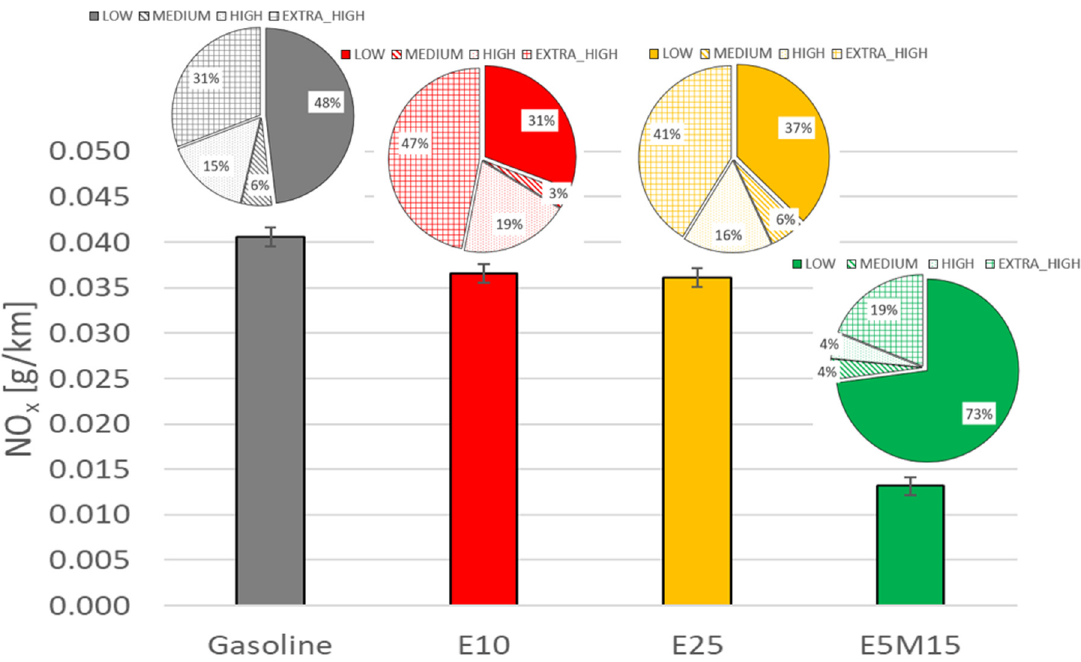
Figure 8. NO x emissions measured at each phase of the cycle for gasoline, E10, E25 and E5M15.